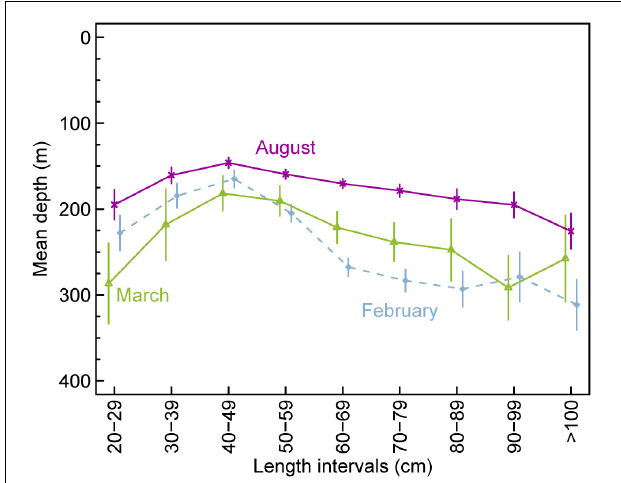
FIGURE 6 | Mean depth distribution of anglerfish versus anglerfish size from the groundfish survey (2000–2020) on the Faroe Plateau in late February/March (lime) and August (purple line), and from the anglerfish survey during February in 2002 and 2003 (stippled light blue line). The bars indicate 95% confidence